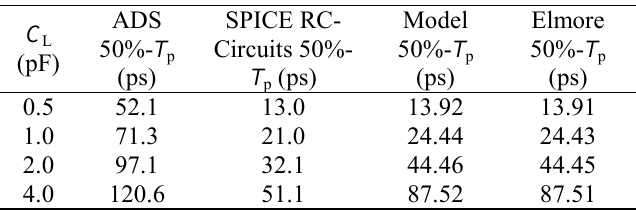
Table 7: Comparison of the 50%-propagation delay computed with SPICE and calculated with the proposed model and the Elmore one versus load C L for the case 2.